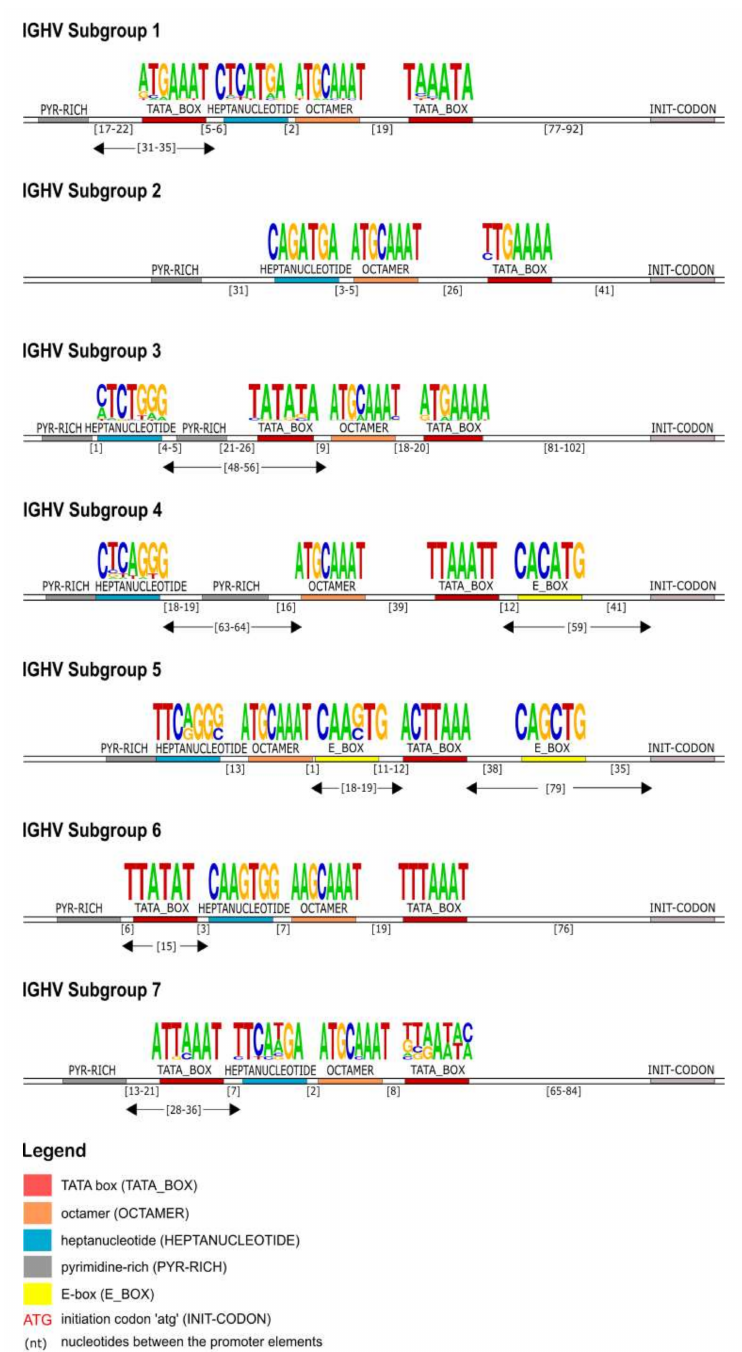
Figure 4. Schematic representation of the IGHV genes promoter organization per subgroup, based on the regulatory elements consensus sequences, positions and distances. Each element is represented by a specific color according to the IMGT color menu for the organization of the V-GENE promoters. The IMGT labels of each element are mentioned in parentheses in the